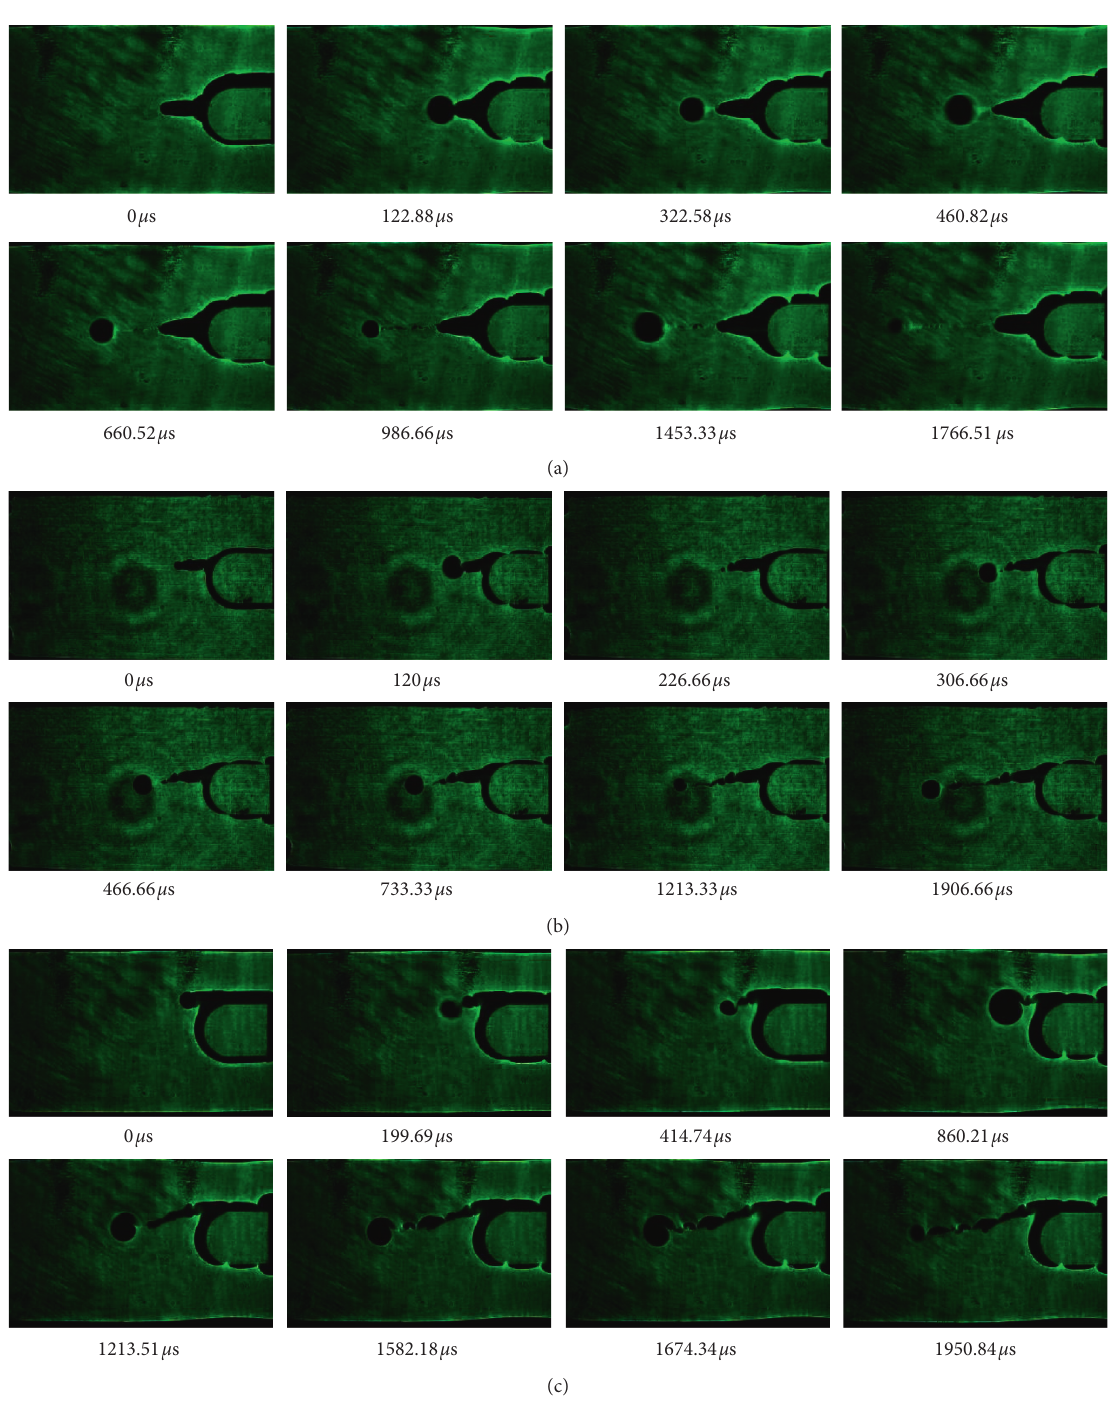
Figure 12: Dynamic caustic image patterns at the crack tip in specimens with different locations of prefabricated cracks. (a) a � 0mm. (b) a � 5mm. (c) a � 10